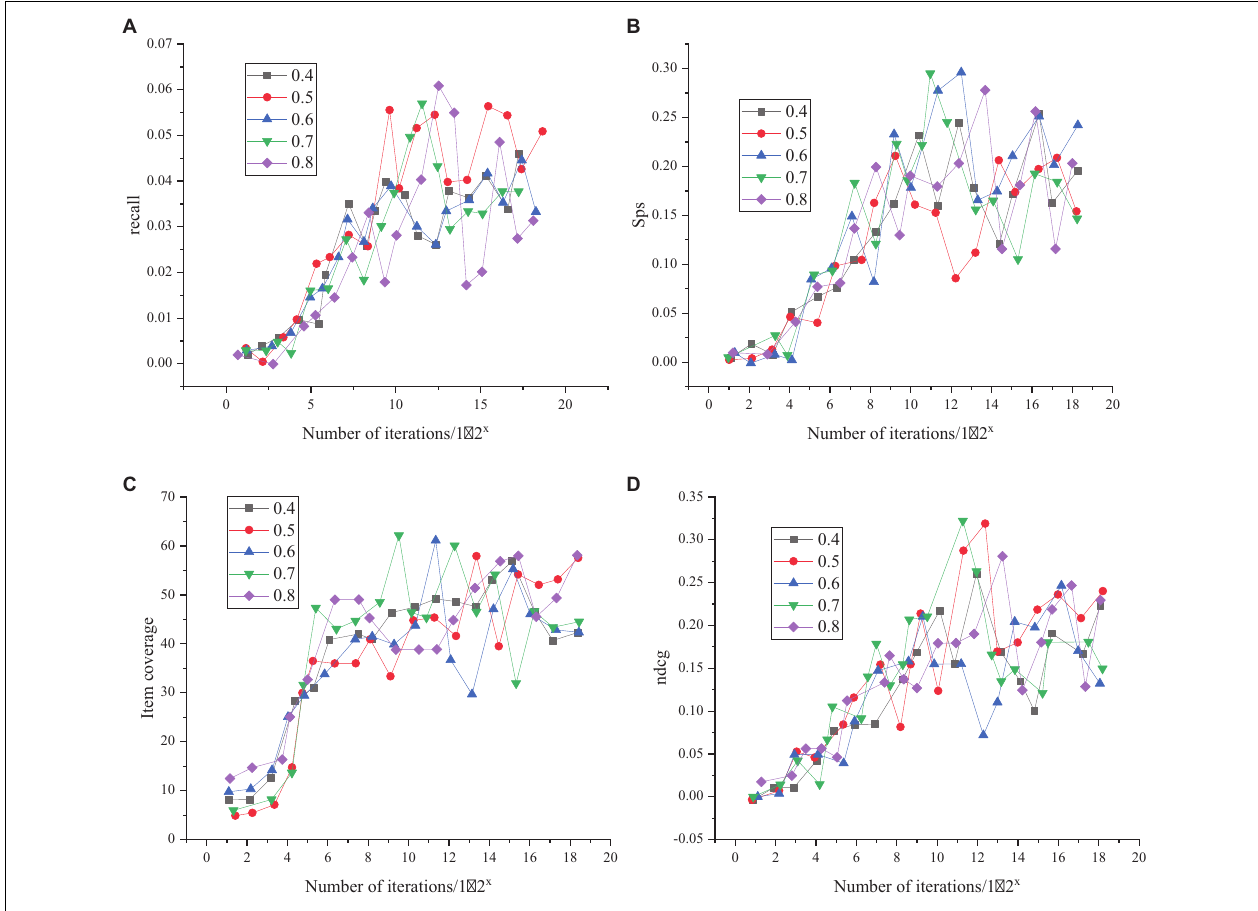
FIGURE 6 | Dropout parameter selection results (A) represents the comparison results of recall under different dropouts, (B) denotes the comparison results of SPS values under different Dropouts, (C) indicates the comparison results of item coverage under different Dropouts, and (D) is the comparison results of item recommended quality under different dropouts, represented by